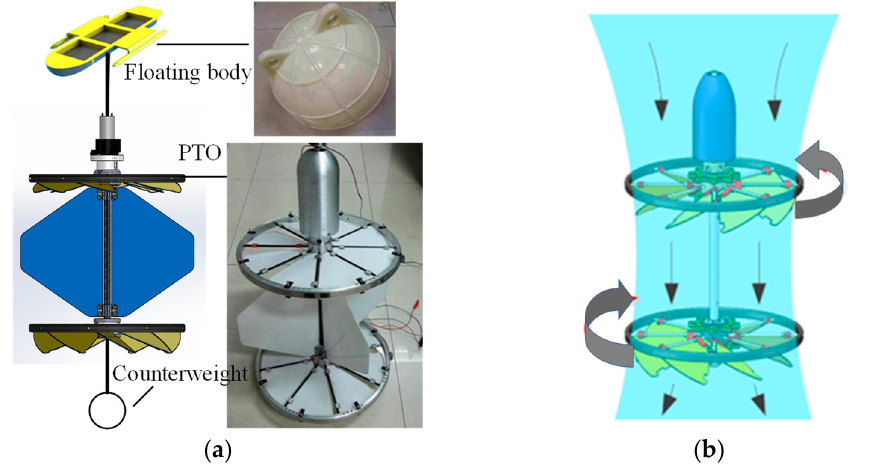
Figure 2. ( a ) Flat ‐ blade PTO; ( b ) working principle.